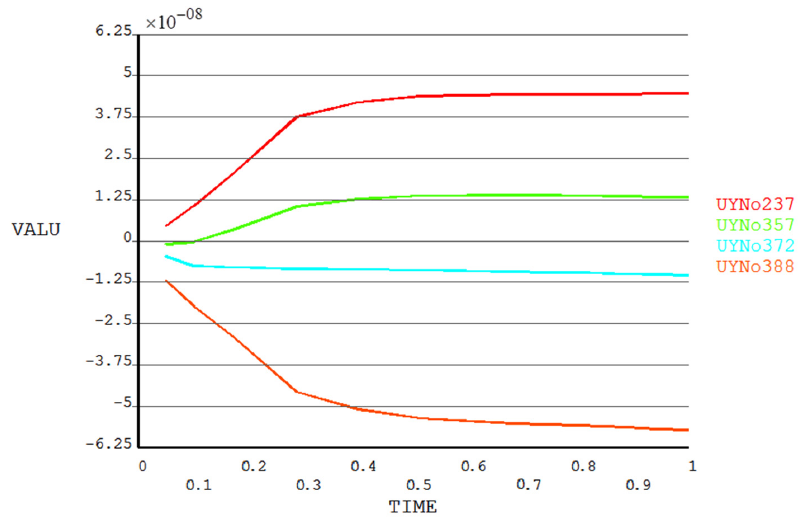
Figure 5. Displacement change with imprinting time of nodes 237, 357, 372, and 388.